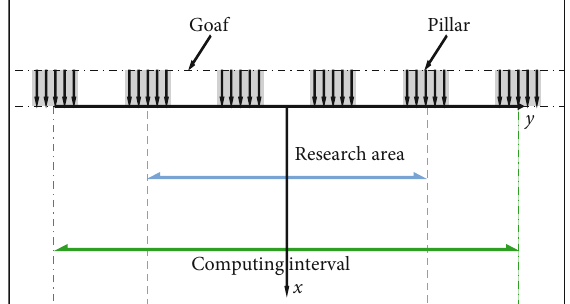
Figure 6: Calculation and study